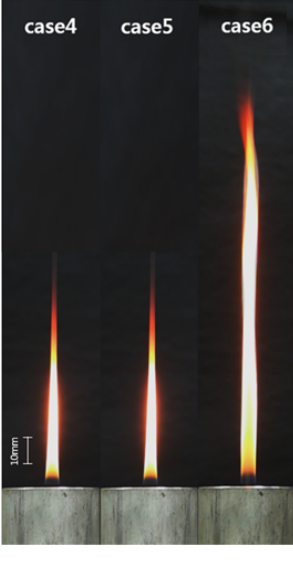
Figure 7. Flame patterns of post combustion simulated gases, including kerosene vapor with different dilutions observed by natural emission imaging method.